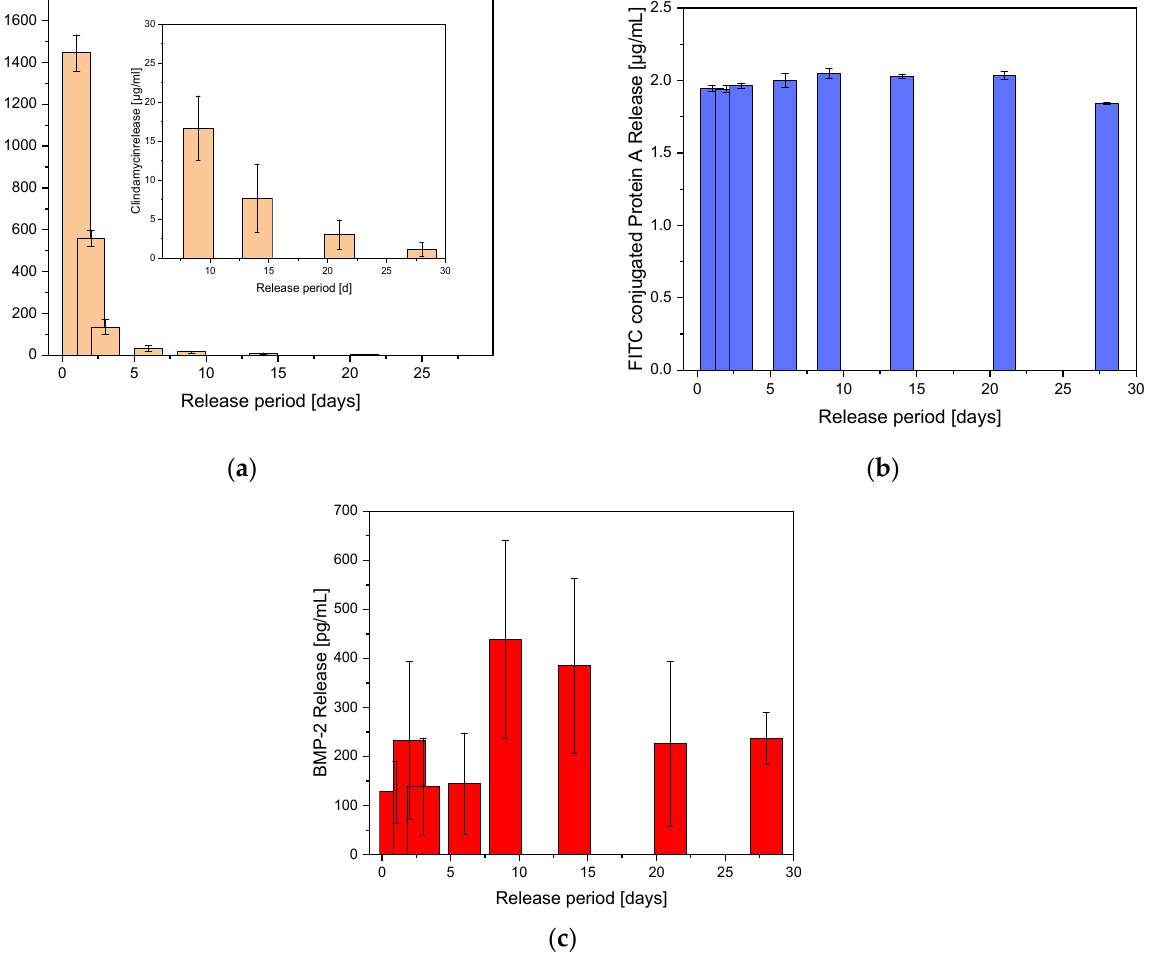
Figure 6. Dual release out of ADA-GEL beads containing GNPs.; ( a ): Clindamycin release over 28 days, the small figure represents an enlargement of the last release times. ( b ): FITC conjugated protein A released out of GNPs within the ADA-GEL beads. ( c ): BMP-2 release out of GNP within the ADA-GEL beads. N = 12.